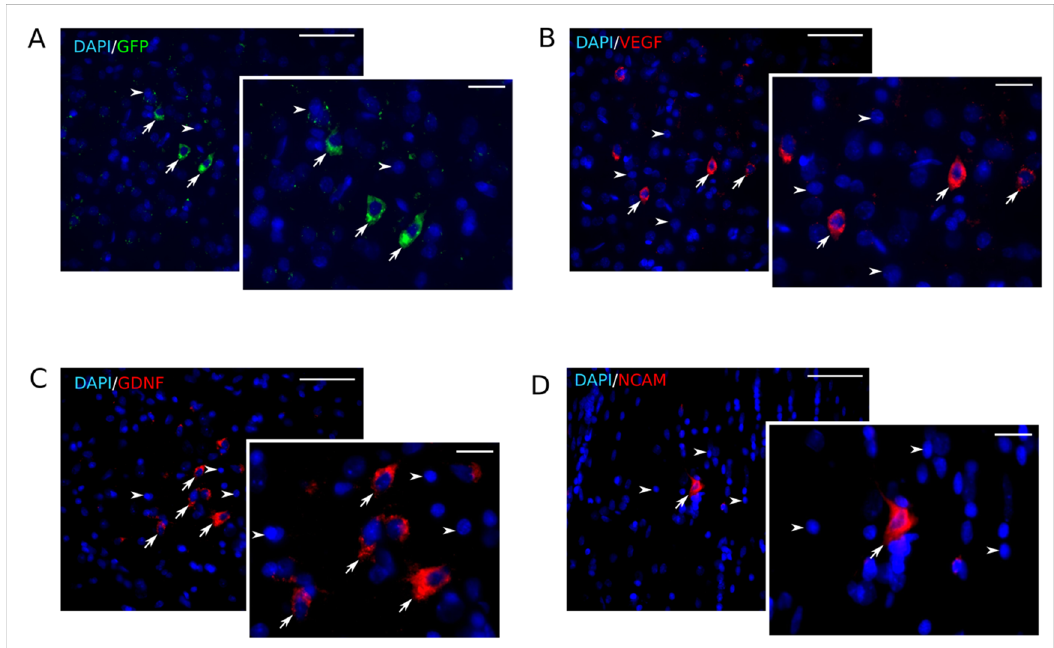
Figure 10. Expression of recombinant molecules in rat brain on 25th day after intrathecal injection of Ad5-GFP and Ad5-VEGF-GDNF-NCAM. ( A )—Specific green glow of GFP in the transduced brain cells. ( B )—Immune reaction with antibody to vascular endothelial growth factor (VEGF) in brain cells (red glow). ( C )—Immune reaction with antibody to glial-derived neurotrophic factor (GDNF) (red glow). ( D )—Immune reaction with antibody to neuronal cell adhesion molecule (NCAM) (red glow). Arrows point to the transduced brain cells. Arrowheads indicate cell nuclei visualized using DAPI (blue glow). Scale bar in ( A – D ) = 50 µm; scale bar in the inserts = 20 µm.